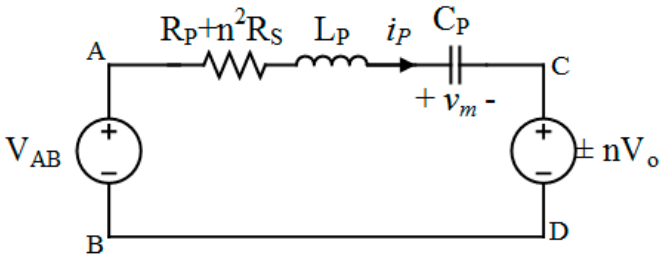
Figure 2. Equivalent circuit of series-series topology.